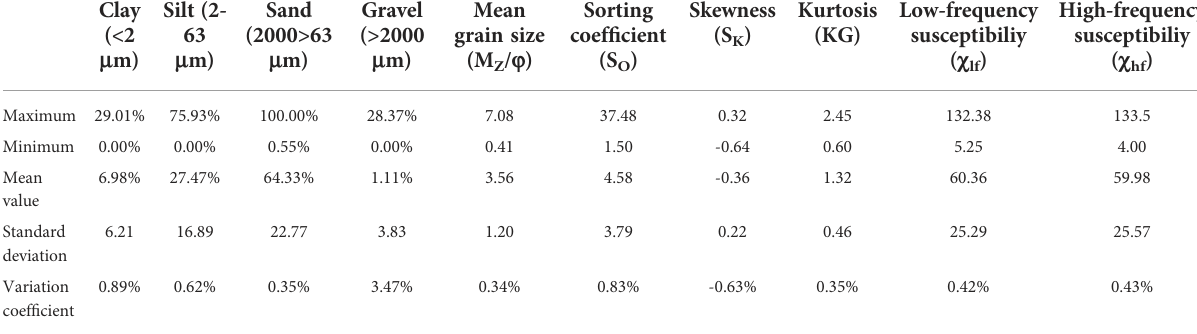
TABLE 4 The grain size composition and parameters characteristics and magnetic susceptibility results of the ZF borehole in Wuhu.